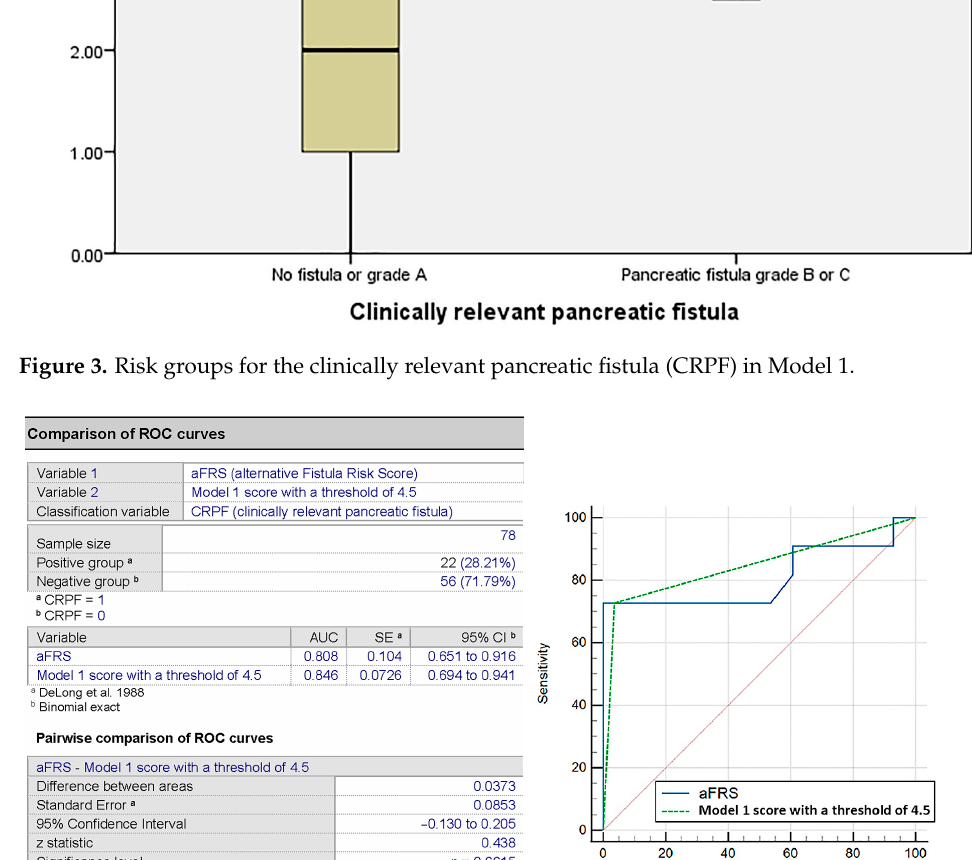
Table 5. Multivariate logistic regression for Model 2.